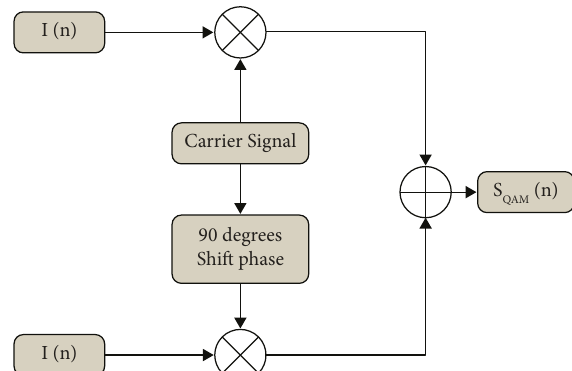
Figure 6: Schematic diagram of digital quadrature amplitude modulation.